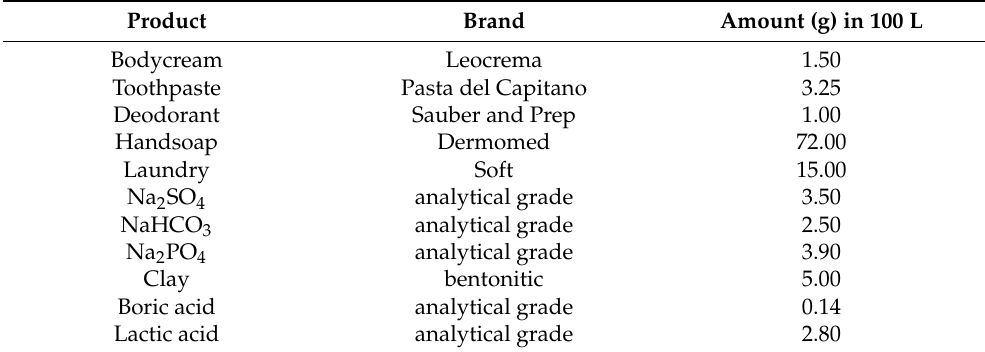
Table 2. Composition of the synthetic greywater (GW) used in this study.